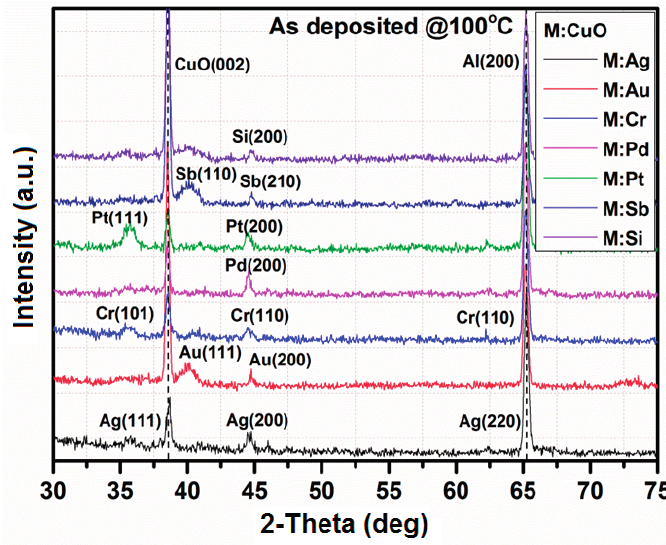
Figure 3. XRD patterns of M:CuO (M: Ag, Au, Cr, Pd, Pt, Sb, Si) doping agents after deposition at 100